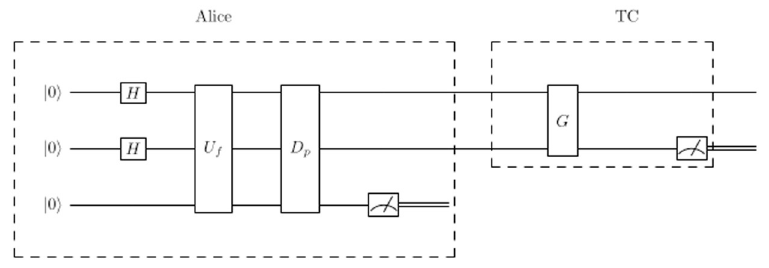
Fig 4. A quantum circuit to send binary-1 on the second qubit where the data is hidden.